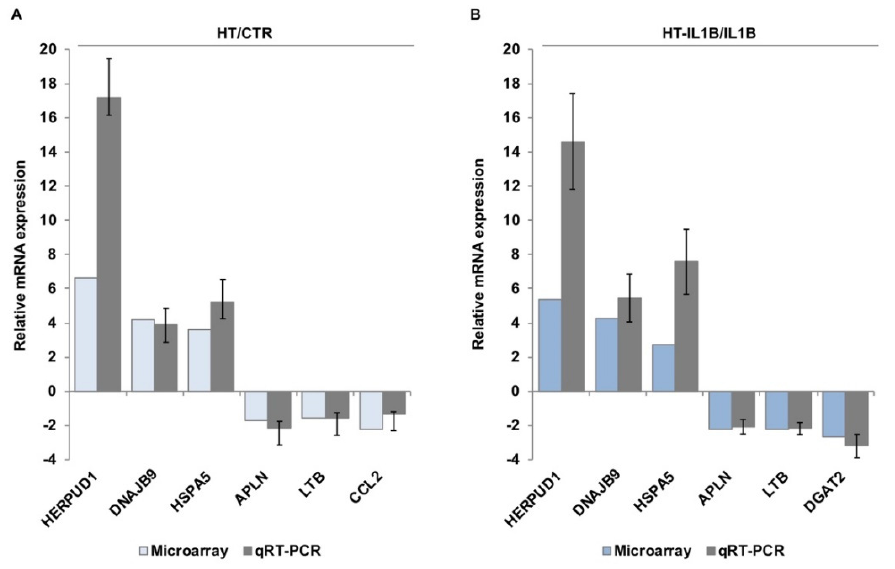
Figure 3. Validation of microarray data by qRT ‐ PCR. HUVECs were treated with/without 10 μ mol/L hydroxytyrosol (HT) for 1 h ( A ) and then stimulated with 5 ng/mL IL ‐ 1 β (IL1B) for an additional 3 h ( B ). qRT ‐ PCR was performed for HERPUD1, DNAJB9, HSPA5 (up ‐ regulated) and APLN, LTB, CCL2 and DGAT2 (down ‐ regulated). The results were expressed as the relative mRNA expression. Each value represents the mean ± SD of three separate experiments. Microarray ‐ based relative mRNA expression was also shown for comparison.